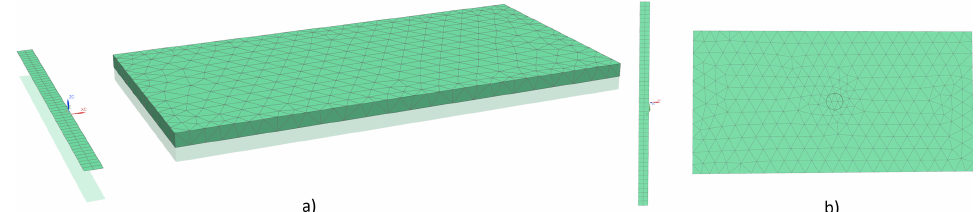
Figure 2. Visualisation of the finite element simulation. ( a ) A 3D representation from the top in order to clearly see the flat bottom hole plate and the 2D mesh for the moving heat source. ( b ) Bottom view of the components. The circular void is placed in the middle of the flat bottom hole plate.